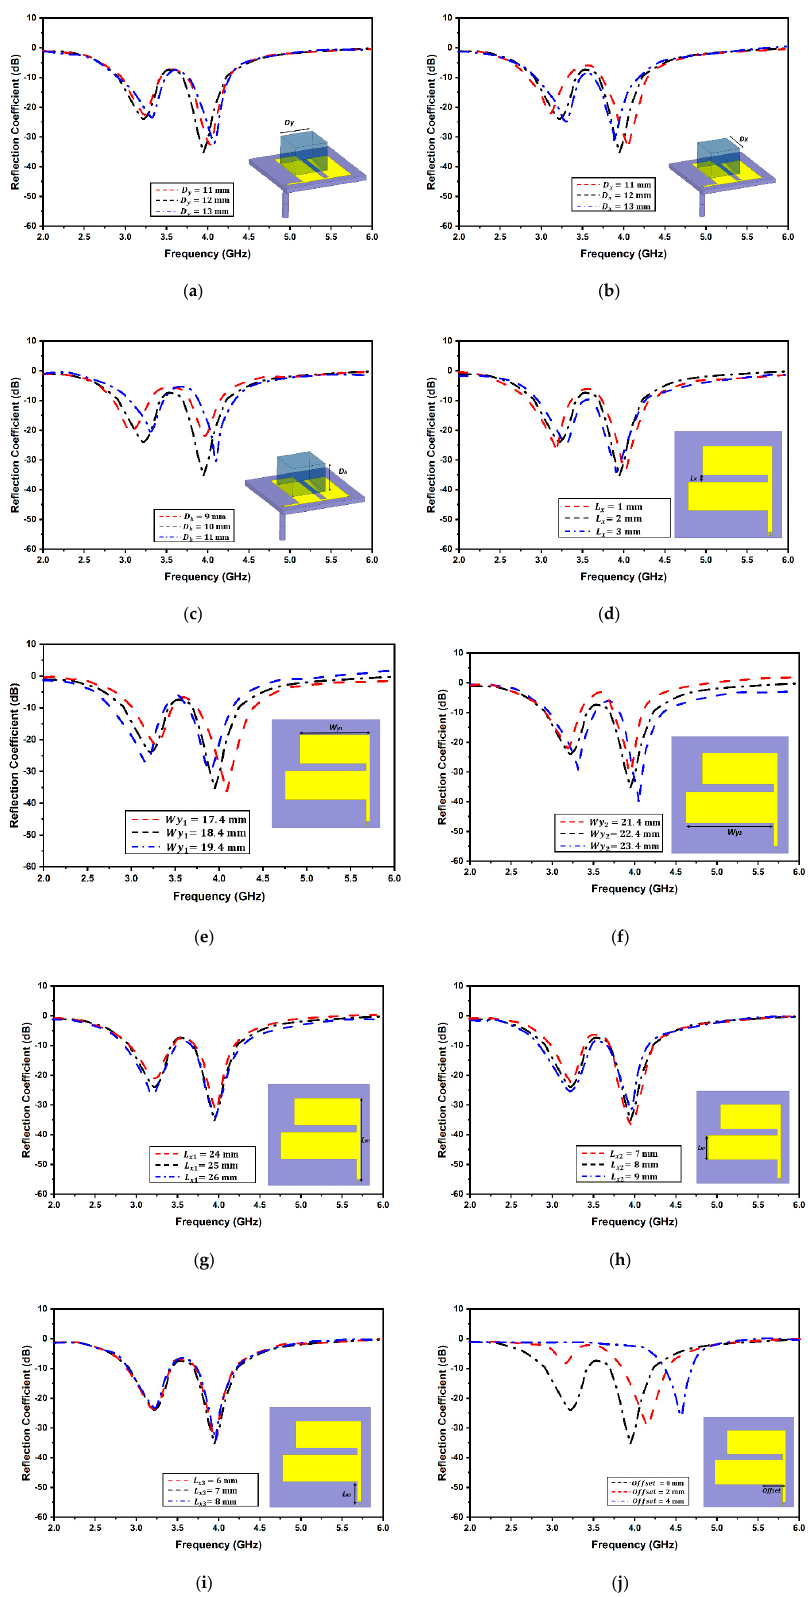
Figure 4. Sensitivity analysis of antenna; ( a ) DR Length D y ; ( b ) DR Width D x ; ( c ) DR Height D h ; ( d ) flare gap; ( e ) upper flare W y1 ; ( f ) lower flare W y2 ; ( g ) length L x1 ; ( h ) width L x2 ; ( i ) length L x3 ; ( j ) offset feed location.